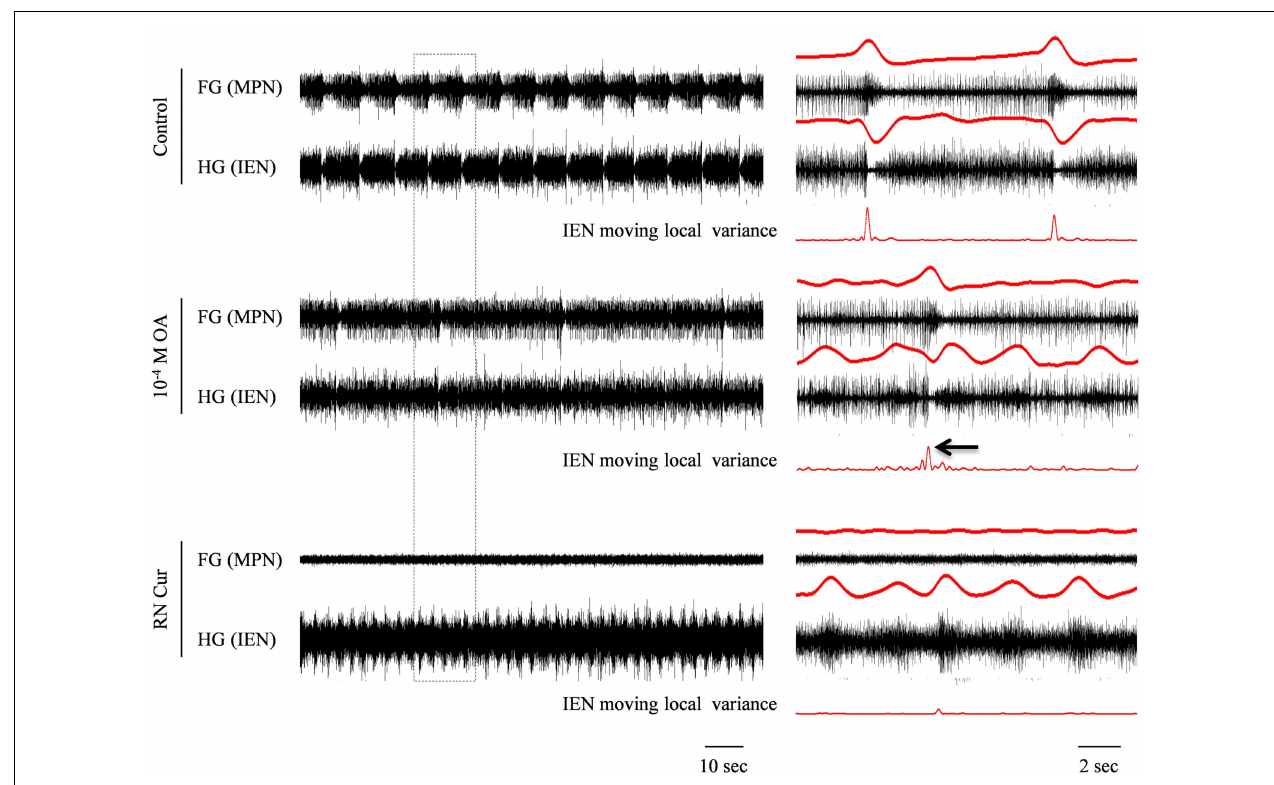
FG + HG bursts and in the appearance of independent HG activity. While the latter is clearly seen in the IEN smoothed signal, the synchronized bursts can still be detected by applying a moving local variance filter. Cutting the RN resulted in complete cessation of the synchronized rhythm seen in both the FG and HG, without affecting the independent HG frequency.